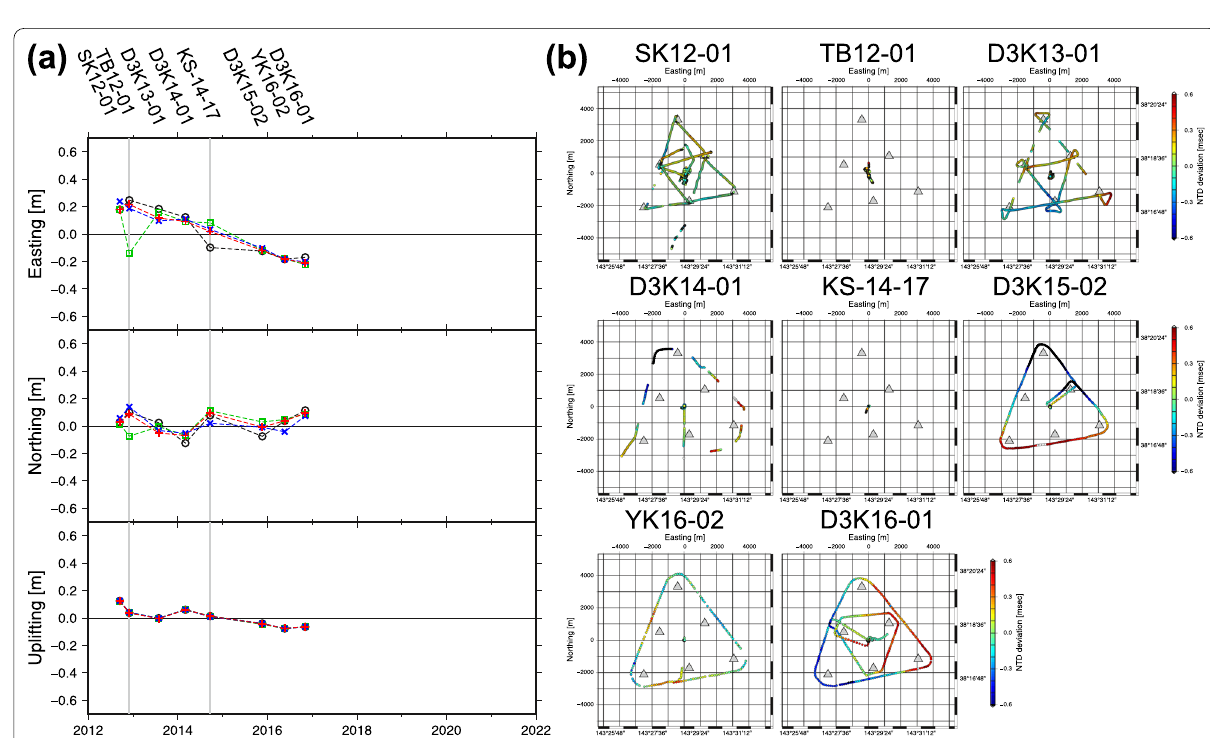
Fig. 10 Time-series of the array positions and sea-surface tracks for campaigns at G10. Each panel is described in the same manner as in Fig.